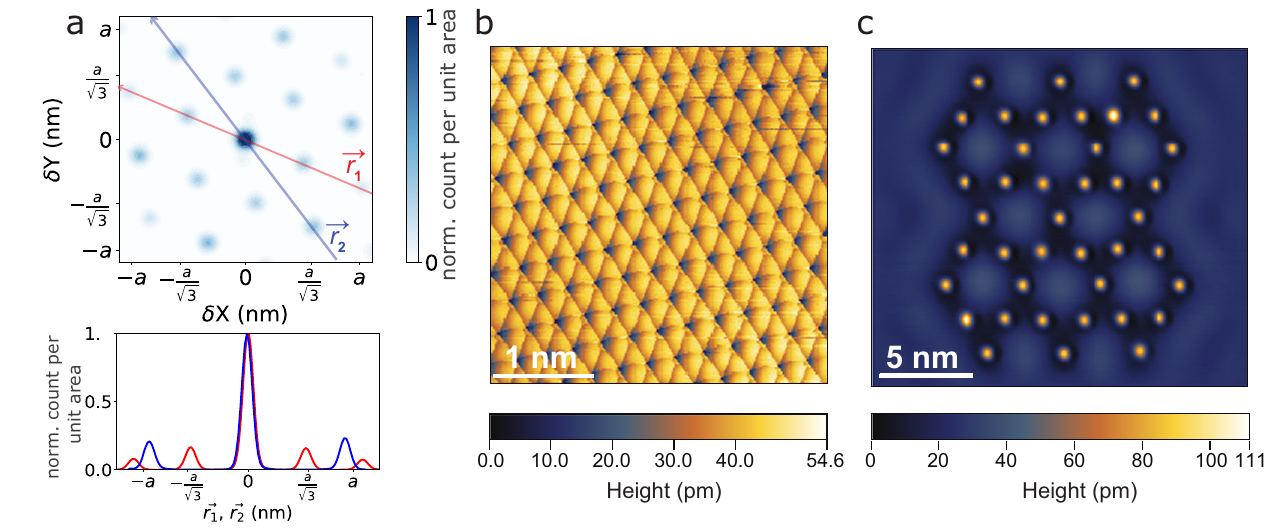
Fig. 3 | Atom manipulation statistics and autonomous construction of an arti fi cial lattice. a Top: Adatom movement distribution following manipulations visualized in a Gaussian kernel density estimation plot. Adatoms are shown to reside both on fcc and hcp hollow sites. Line-cuts in two directions ~ r 1 and ~ r 2 (indicatedbytheblueandredarrows)areshowninthebottom fi gure. b Atomically